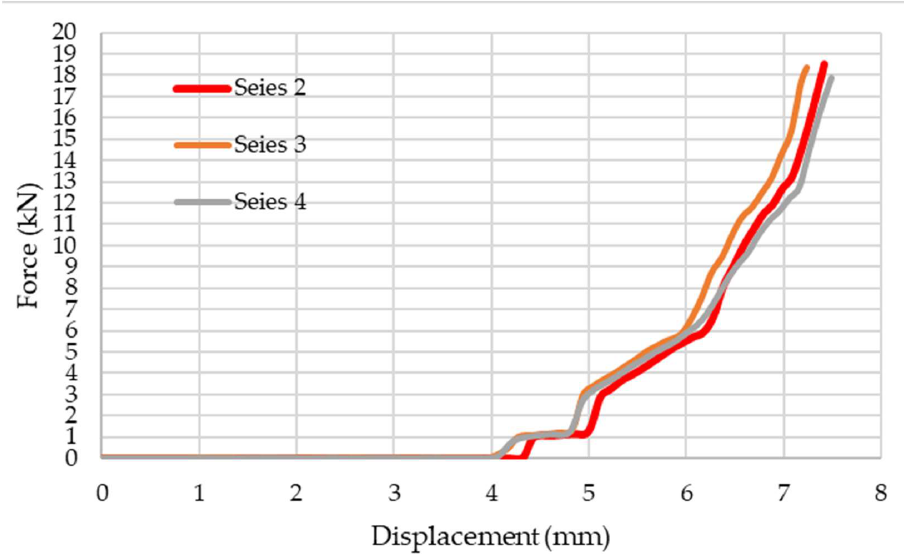
Figure 6. Execution of sheet metal clinching; ( a ) the device used to prepare clinching joint, ( b ) spec- imen from the first testing series, ( c ) specimen from the second testing series, ( d ) specimen from the third testing series.